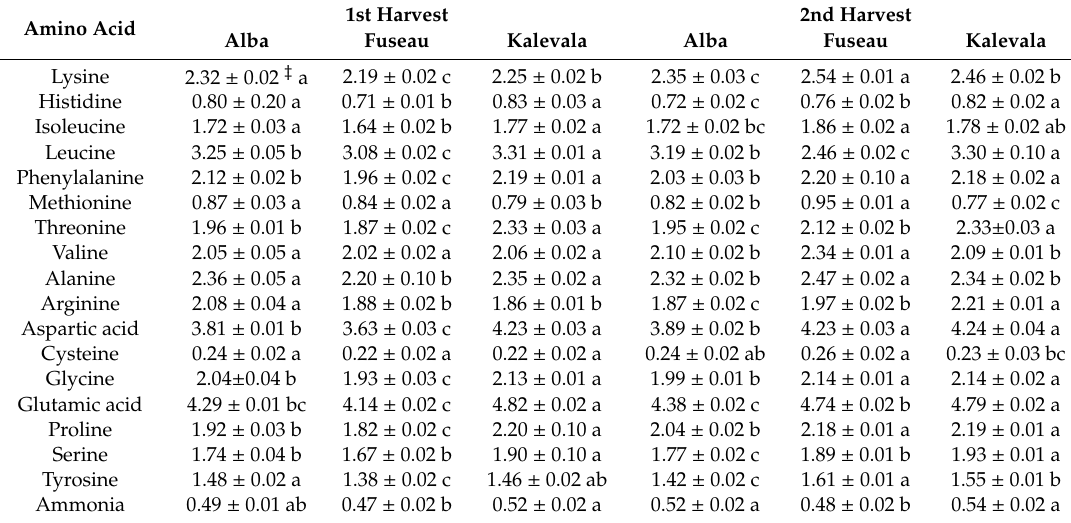
Table 2. Amino acid profile (m / m%) of Jerusalem artichoke leaf protein concentrate (JAPC) extracted from green biomass of di ff erent